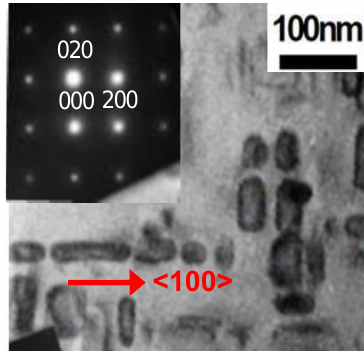
Figure 1. Bright-field transmission electron micrograph and the selected area electron diffraction pattern of the Cu 75 Ni 20 Fe 5 sample.